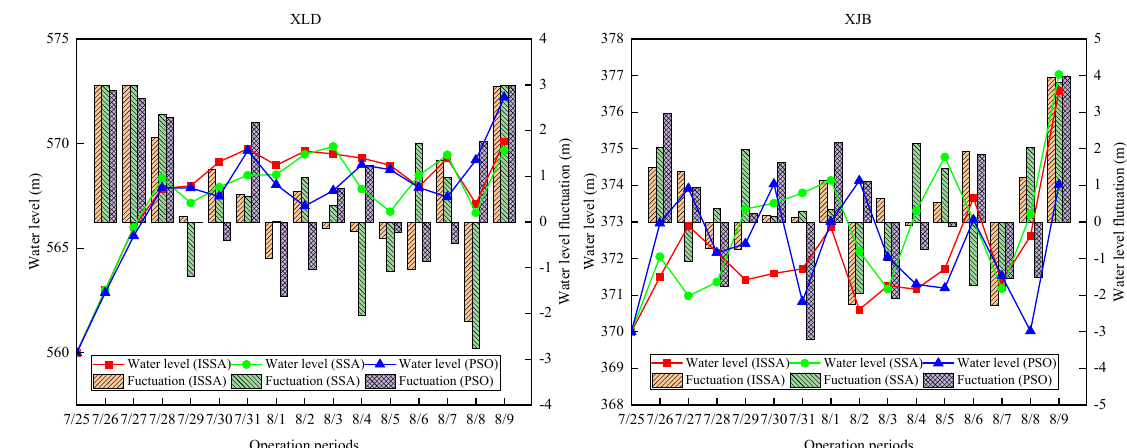
Figure 11. Water level processes of XLD and XJB.